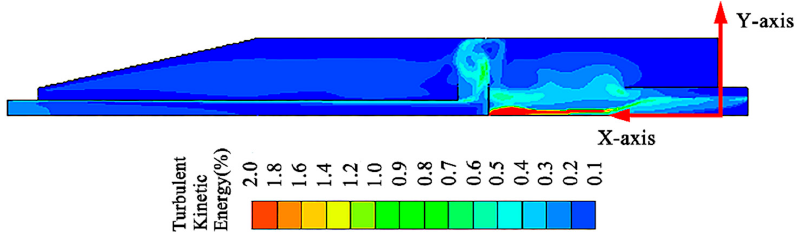
Figure 8. Turbulent intensity distribution of the central section (rotational speed is 900 r/min).